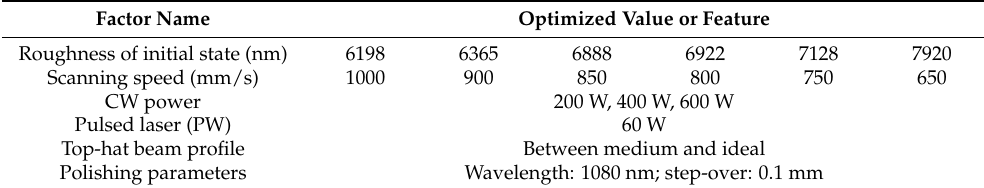
Table 5. Optimized parameters of dual-beam laser polishing.